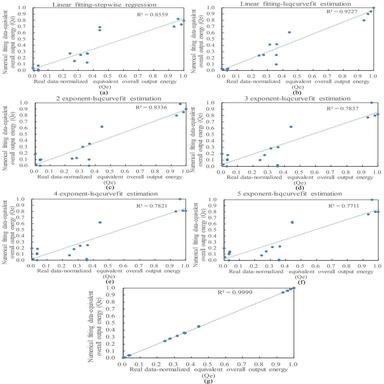
(a)–(f) Correlation analysis of the normalised objective using the mathematical fitting methods; (g) Correlation analysis of the normalised objective using the supervised machine learning technique.